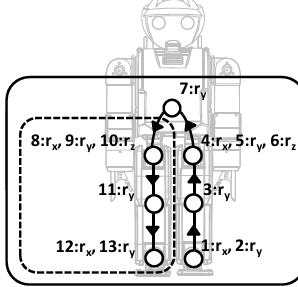
kicking motion, we focus on the course of the ball. We performed two types of kicking motion for Environments 1 and 2; kicking a ball on the ground and in the air,